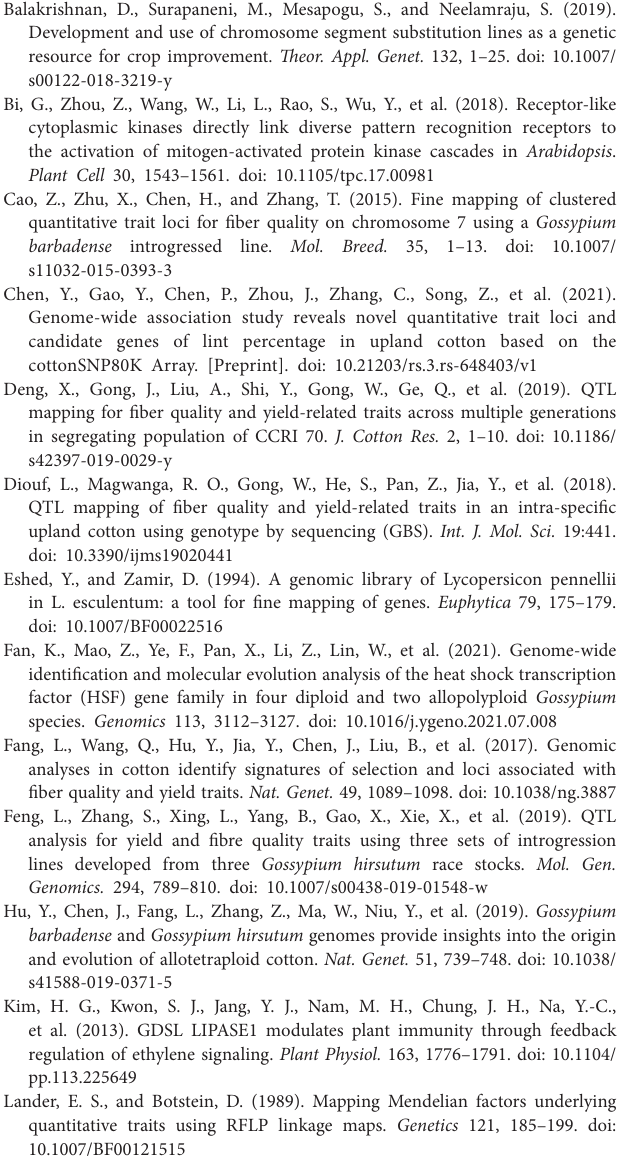
Supplementary Table S16 | Putative candidate genes within the intervals of the stable QTL. Supplementary Table S17 | Primers sequences used in qRT-PCR. Supplementary Table S18 | SNP variation in the upstream and coding region of candidate genes. Supplementary Table S19 | Comparison of QTL identified in this study with those reported in previous studies. Supplementary Table S20 | Comparison of QTL identified in this study and previous GWAS